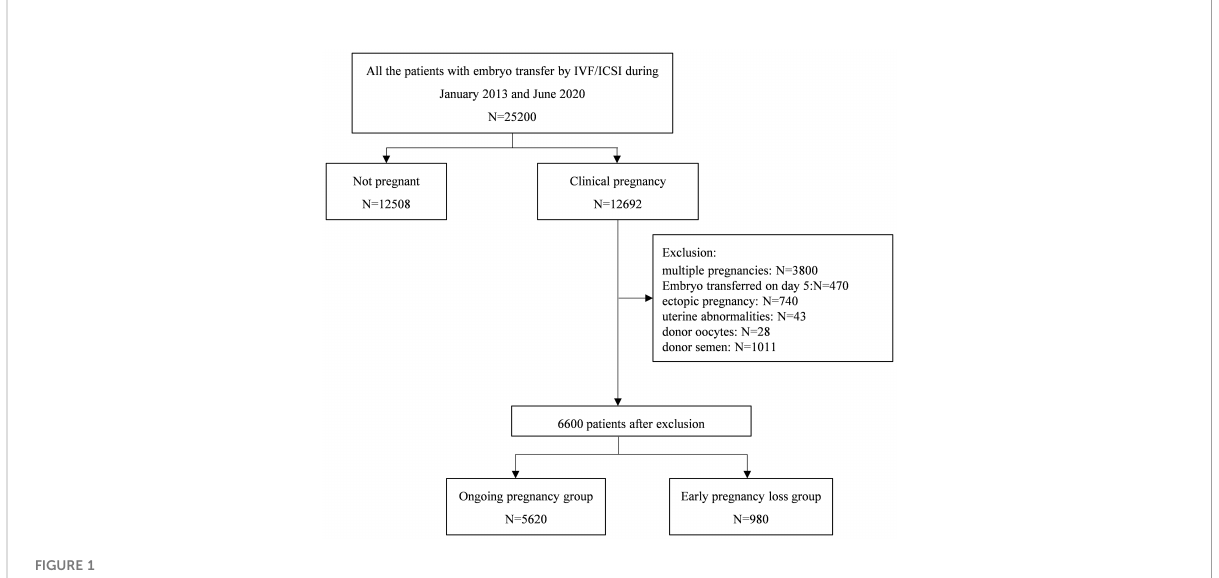
FIGURE 1 Flow chart of the